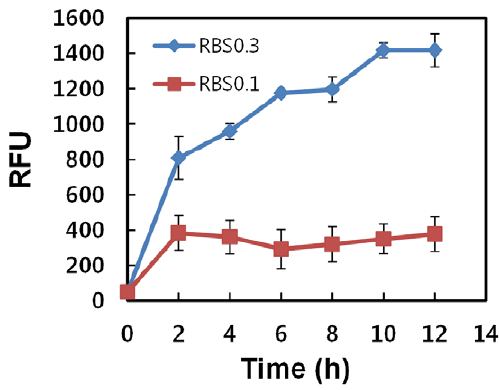
Figure 6. Switchable control of GFP expression. Graph shows variation in GFP expression with respect to an oscillating light source (light/dark cycle at 2-h intervals) from JM1013 (diamonds) and JM1014 (squares) strains. Data are presented as mean 6 SD and basal values were not subtracted. This experiment was performed using the same culture method as described in Fig. 3. RBS0.3, strong RBS; RBS0.1, weak RBS.